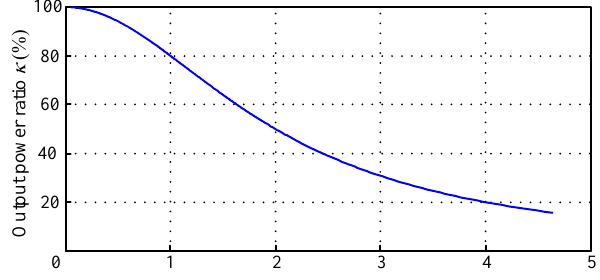
Figure 4. The output power ratio curve.